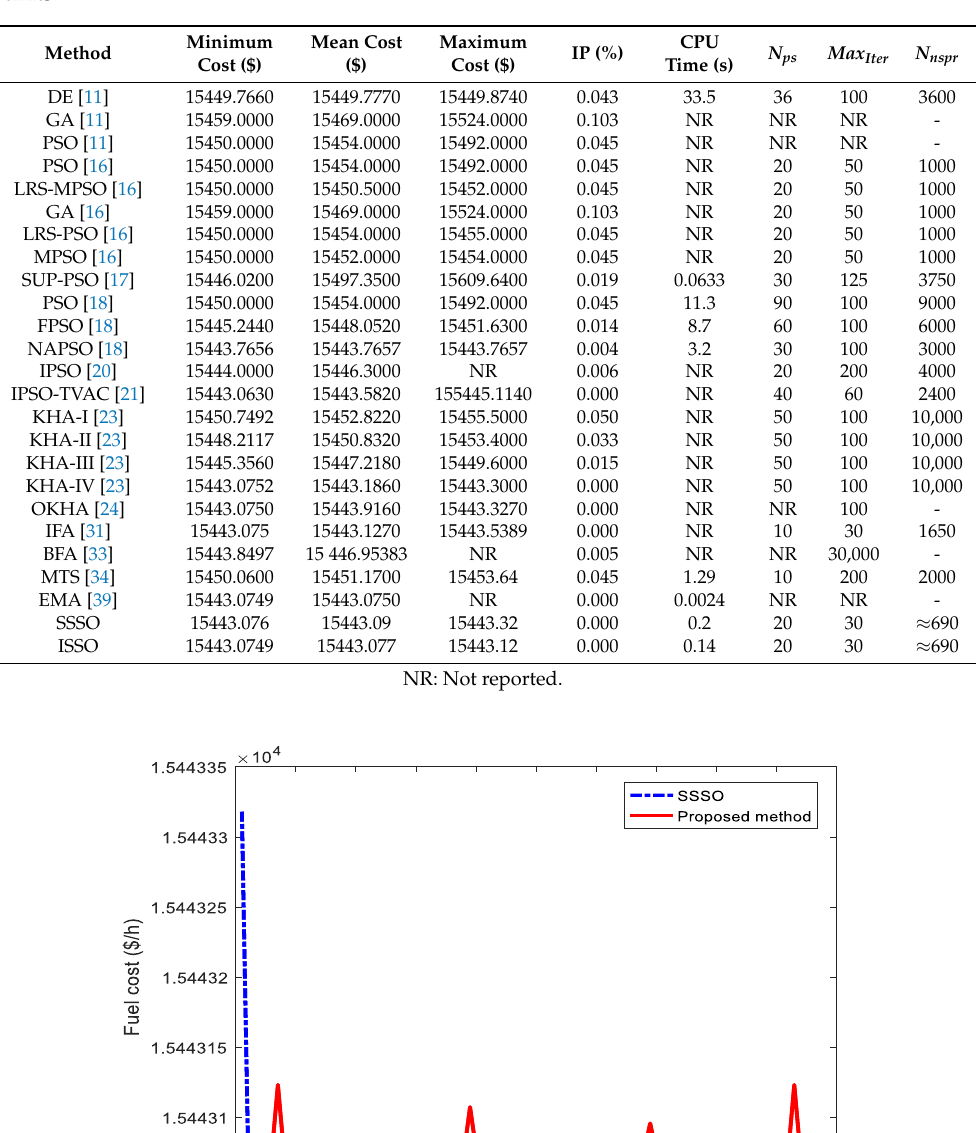
Table 3. Result summary obtained by different methods and the proposed method for system 1 with 6 units.